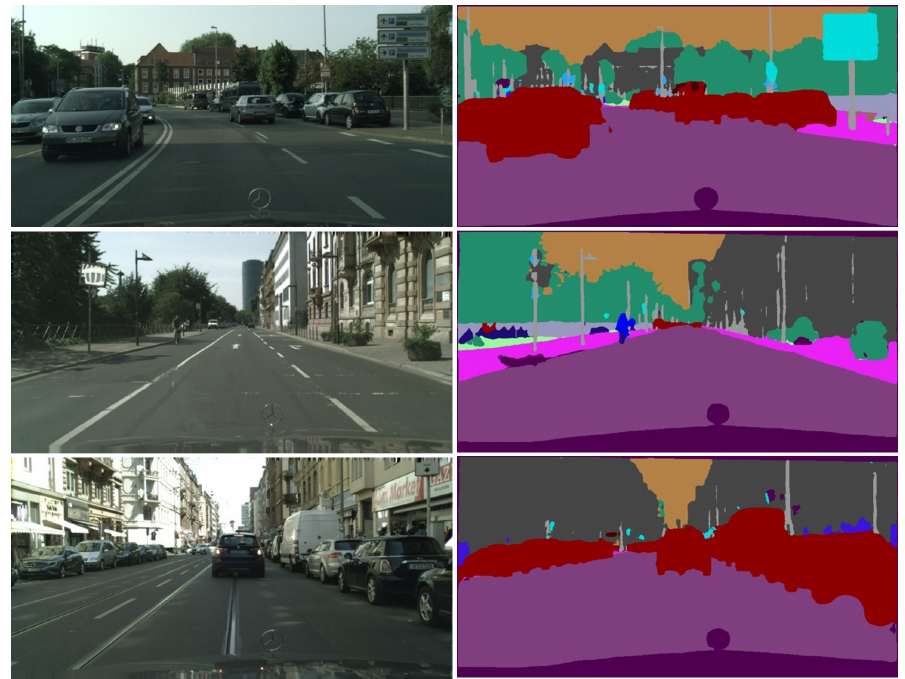
Figure 11. Prediction results of the EfferDeepNet network.